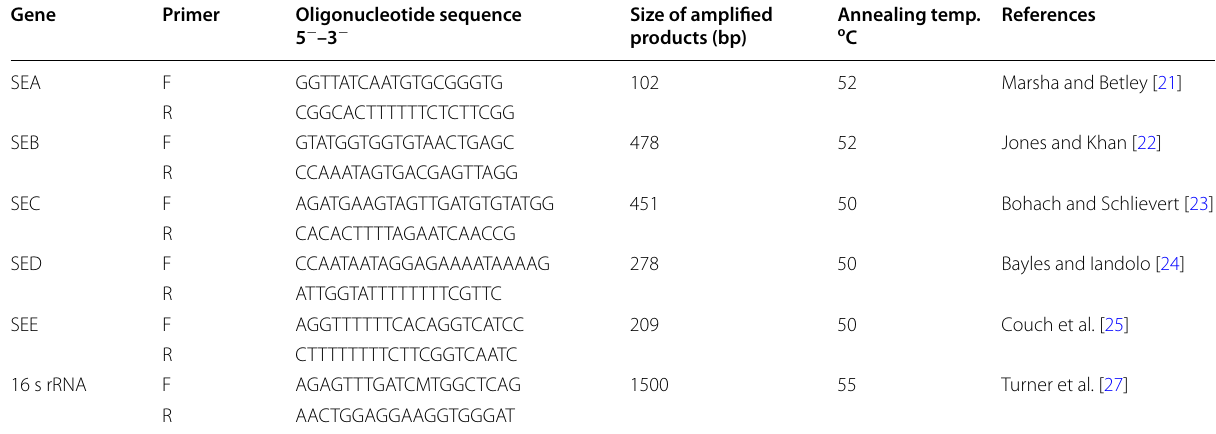
Table 1 Oligonucleotides primers used in the study Gene Primer Oligonucleotide sequence 5 − –3